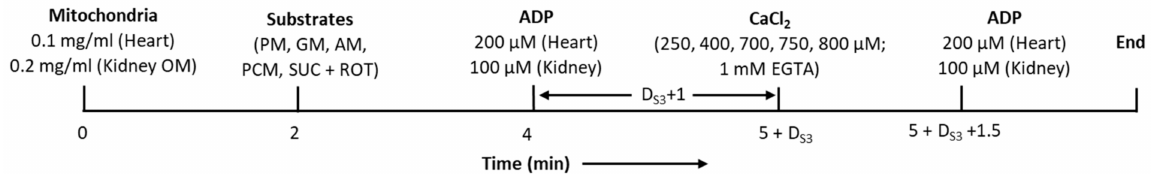
Figure 1. Timeline of the experimental protocol (in minutes) for isolated heart and kidney OM mitochondrial respiration experiments under different metabolic substrates at various Ca 2+ concen- trations. The mitochondria were added at t = 0 min and the substrates and ADP were added at t = 2 min and t = 4 min, respectively. Different concentrations of Ca 2+ , ranging from 250 µ M to 800 µ M, were added 1 min after reaching steady state 4 respiration, and this was followed by the addition of the same ADP concentration as the first ADP perturbation. D S3 : state 3 duration for the first ADP addition. PM: pyruvate + malate, GM: glutamate + malate, AM: alpha-ketoglutarate + malate, PCM: palmitoyl- L -carnitine + malate, SUC + ROT: succinate +